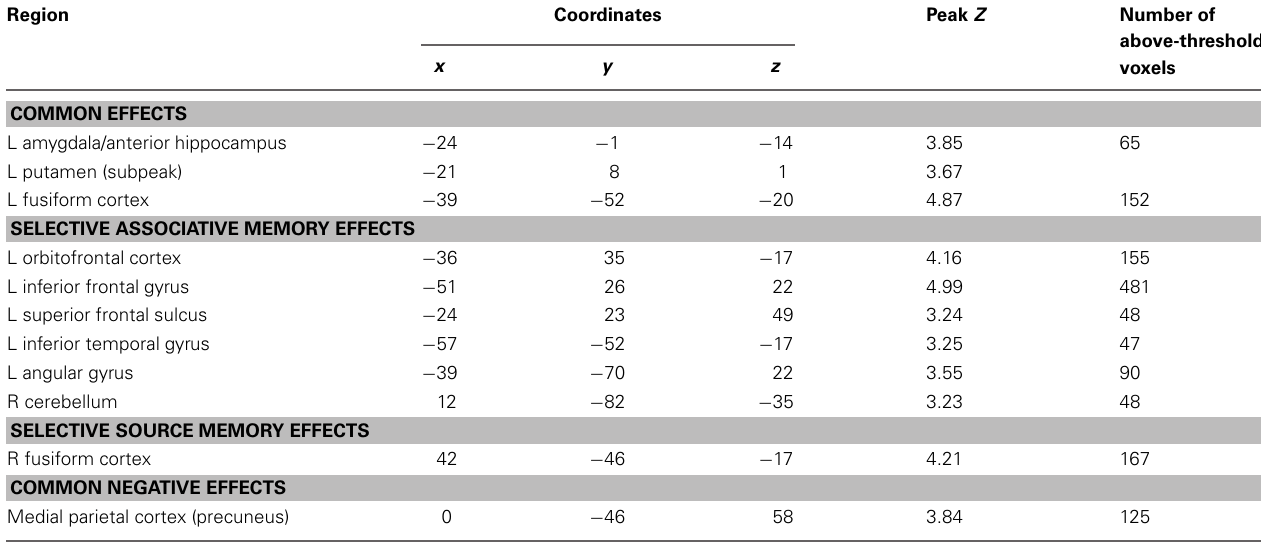
Table 2 | Loci of subsequent memory effects. Region